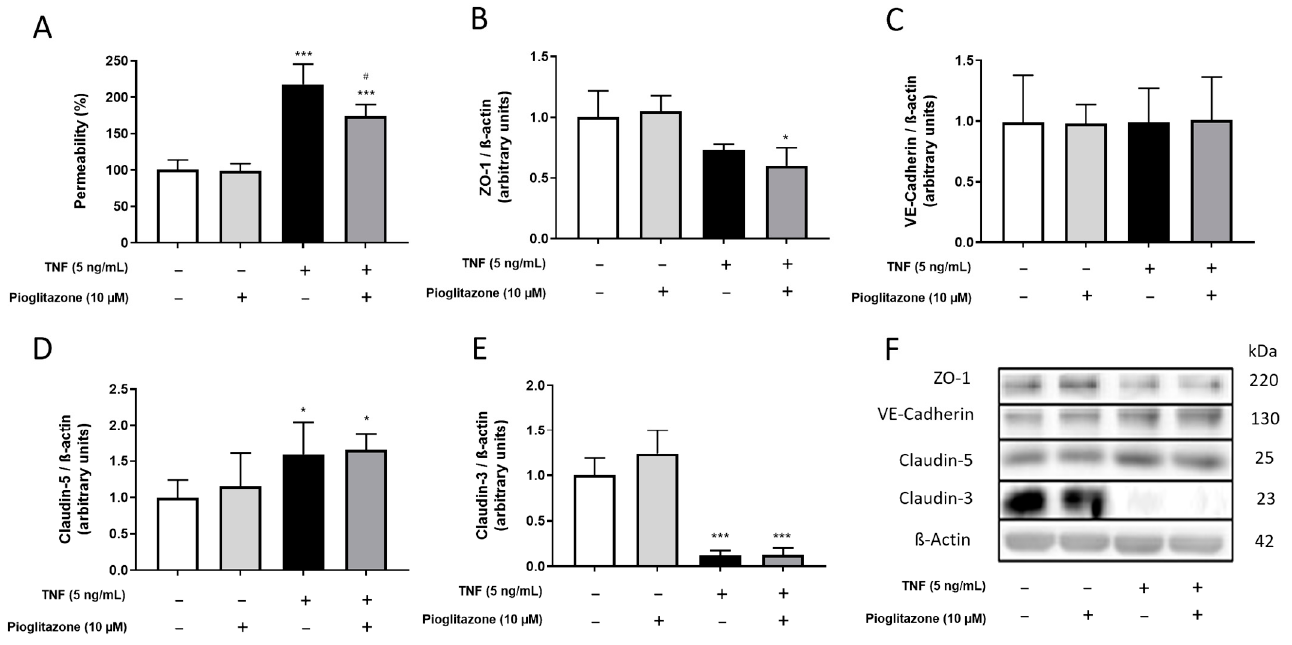
Figure 3. Effects of pioglitazone on TNF α -induced permeability alterations and junctional pro- tein expression. BLECs were treated with 5 ng/mL of TNF α for 24 h following pre-treatment with 10 µM pioglitazone for 24 h. Permeability to NaFlu ( A ) and expression of junctional proteins ZO1, VE-cadherin, claudin-5 and claudin-3 by Western blotting ( B – F ) were assessed. Results are shown as mean ± standard deviation (n = 4) and were analyzed via one-way ANOVA followed by Tukey’s post hoc test. *, *** p < 0.05 and 0.001 in comparison to control groups; # p < 0.05 in comparison to TNF α -treated group. Permeability value of controls = 0.65 ± 0.09 × 10 − 3 cm/min.